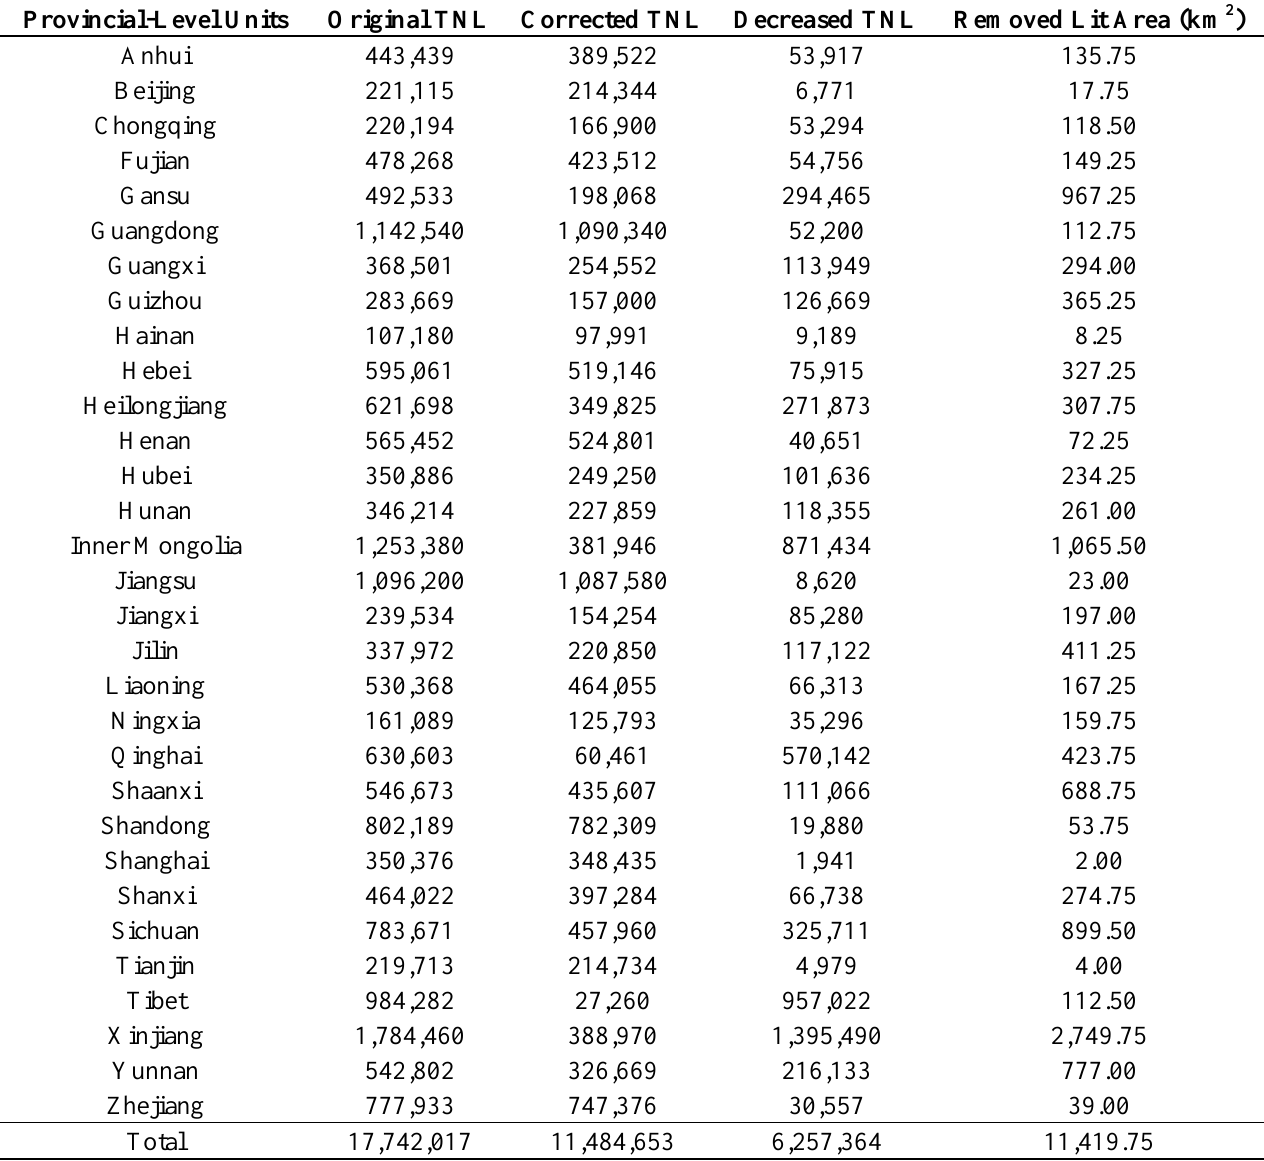
Table 4. Decrease of the total nighttime light (TNL) value and lit area after